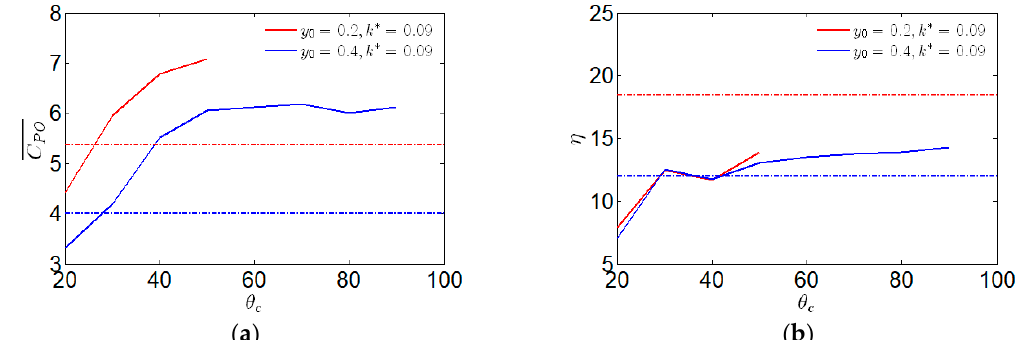
Figure 17. Comparison of (a) the mean value of the output power coefficient and (b) the propulsive efficiency for 𝑦 (cid:2868) = 0.2 and 0.4 and 𝜃 (cid:3030) = 20 − 90 (cid:3042) . The two dotted lines indicate the propulsive performance of the foil, without considering the influence of the critical pitching amplitude for 𝑦 (cid:2868) = 0.2, 𝑘 ∗ = 0.09, 𝑓 ∗ = 0.68 , and 𝑦 (cid:2868) = 0.4,𝑘 ∗ = 0.09, 𝑓 ∗ = 0.34 .